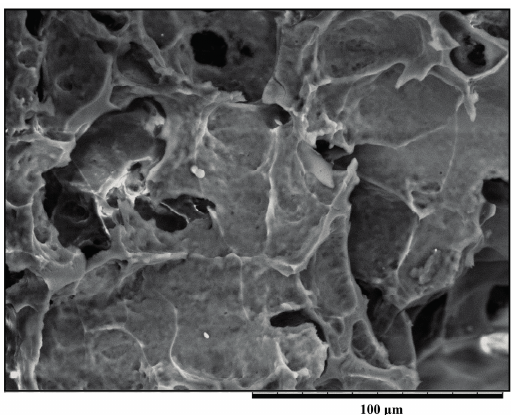
Figure 6. Scanning electron microscopy image of a milk MPF sample treated with 0.8% chitosan.